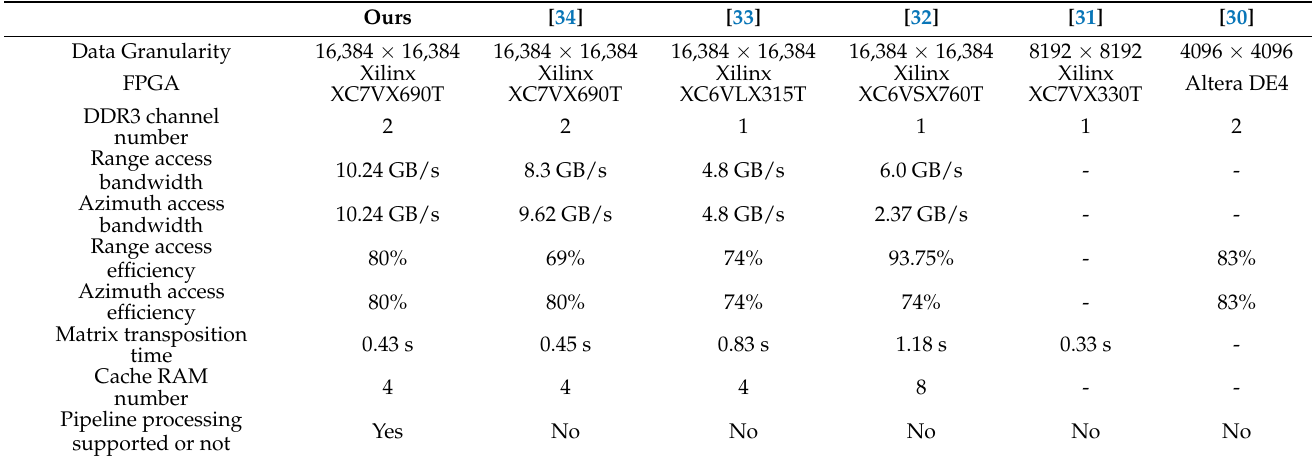
Table 6. Comparisons with previous